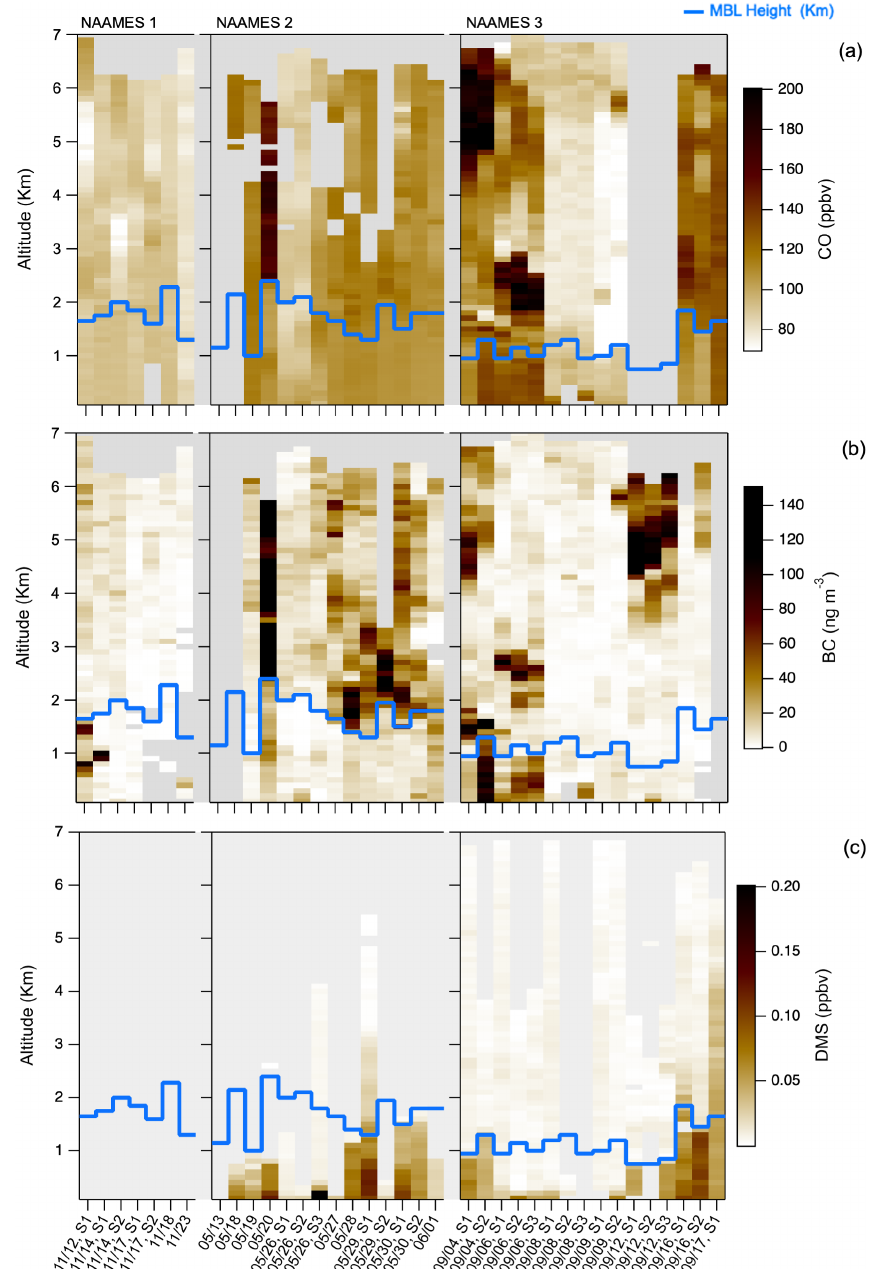
Figure 4. Vertical profile CO (a) , black carbon (b) , and DMS (c) during NAAMES-1, NAAMES-2, and NAAMES-3.